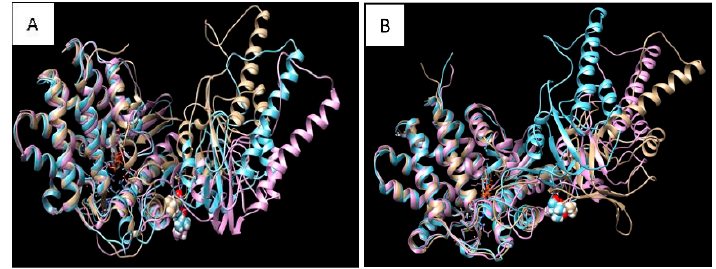
Figure 3. Protein conformational status for wild type and mutant CCT5 proteins. Image ( A ) is the superposition of the most probable conformations obtained from the molecular dynamics simulation of wild type CCT5 without nucleotide (gold), or bound to ATP (lilac), or bound to ADP (cyan). The image shows that the protein takes different conformations in the three conditions, especially at the level of the apical domain. Image ( B ) is the superposition of the most probable conformations obtained from the molecular dynamics simulation of mutant Leu224Val CCT5 without nucleotide (gold), or bound to ATP (lilac), or bound to ADP (cyan). The image shows that the mutant protein takes di ff erent conformations as compared with the wild type in the three conditions examined, especially at the level of the apical